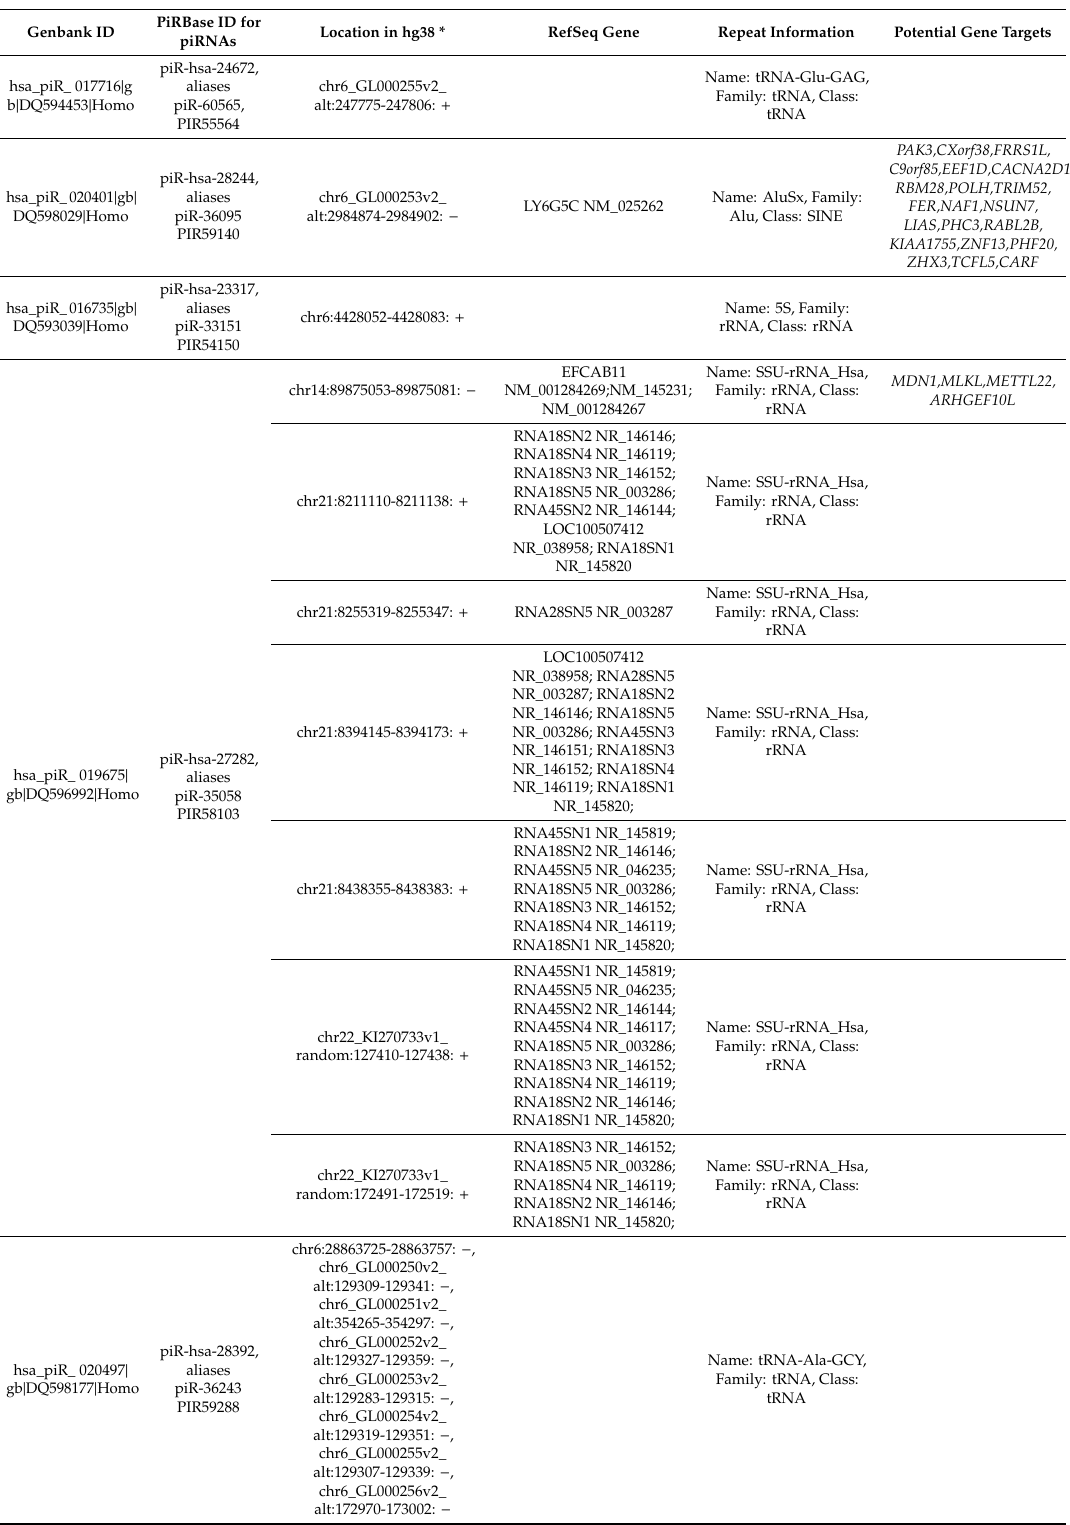
Table 3. Genomic localization and potential piwiRNA target